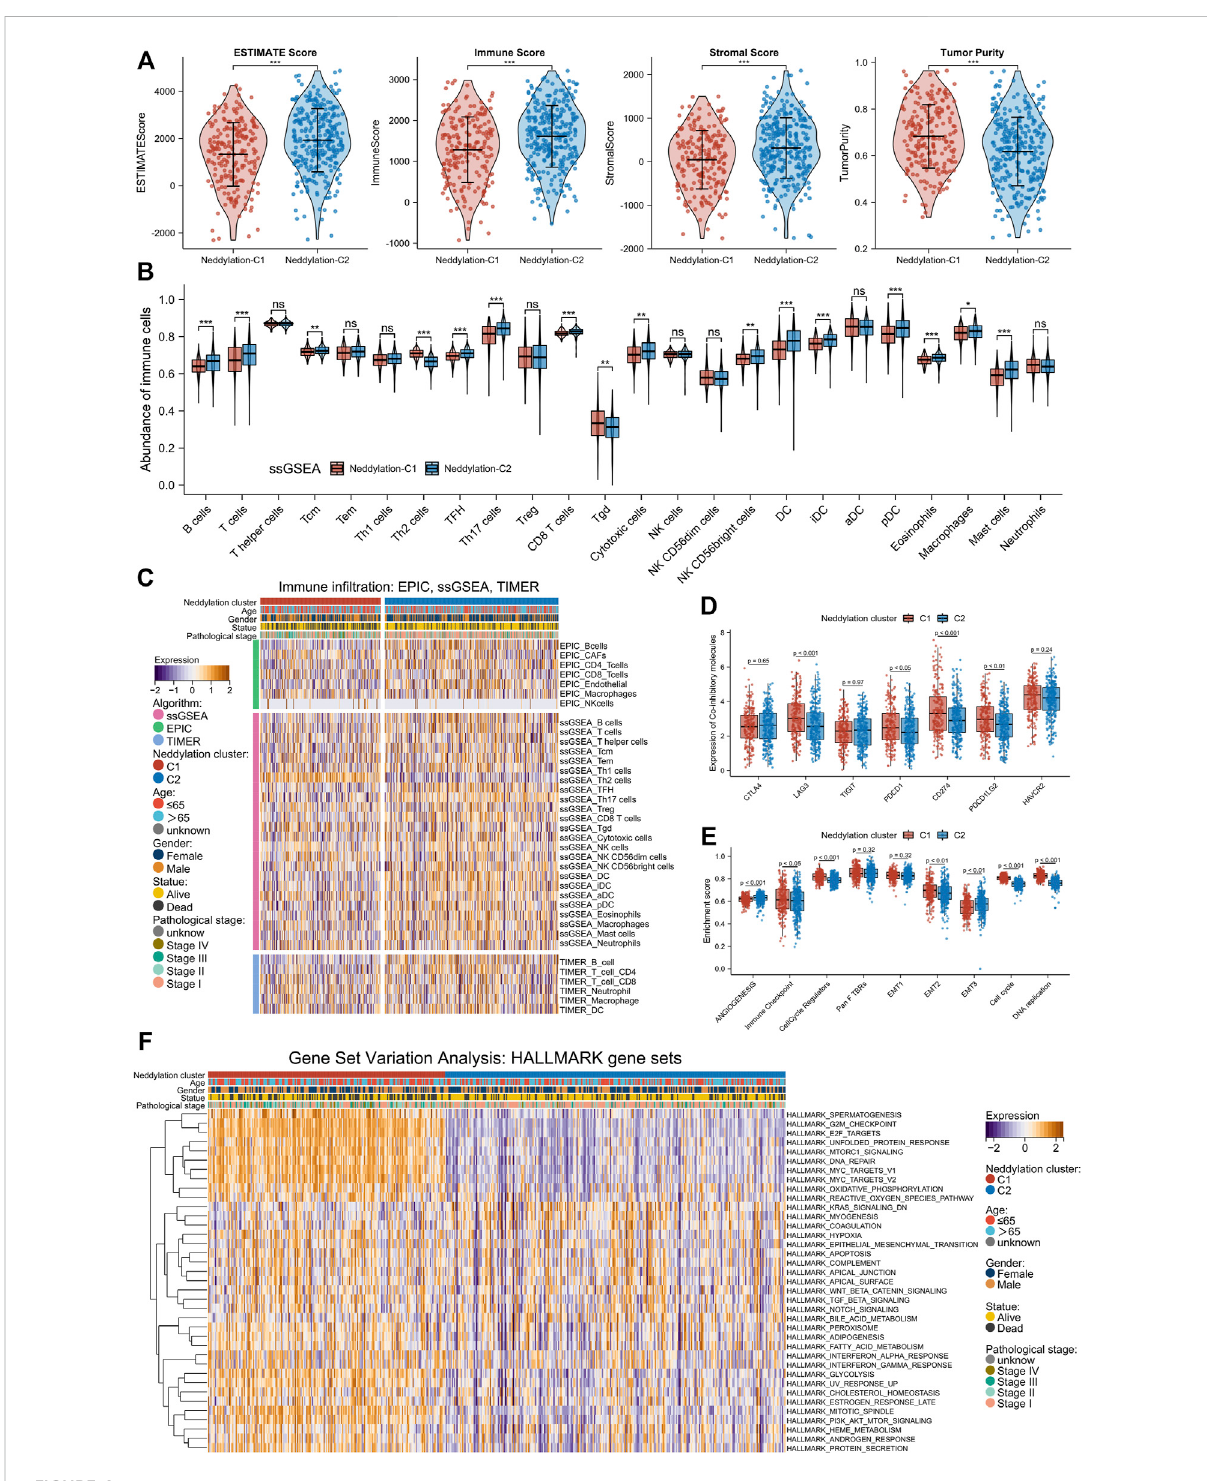
FIGURE 4 Two patterns revealed differences in TME and biological function. (A) ESTIMATE score, immune score, stromal score, and tumor purity of the two patterns. (B) Abundance of in fi ltration of 24 immune cells calculated by ssGSEA algorithm. (C) Differences in immune in fi ltration abundance between different patterns and clinical factors (EPIC, TIMER, ssGSEA algorithm). (D) Differences in expression of immune co-inhibitors between the two subtypes. (E) Calculation of enrichment scores of nine gene sets using ssGSEA algorithm. (F) Statistical differential pathways obtained by GSVA